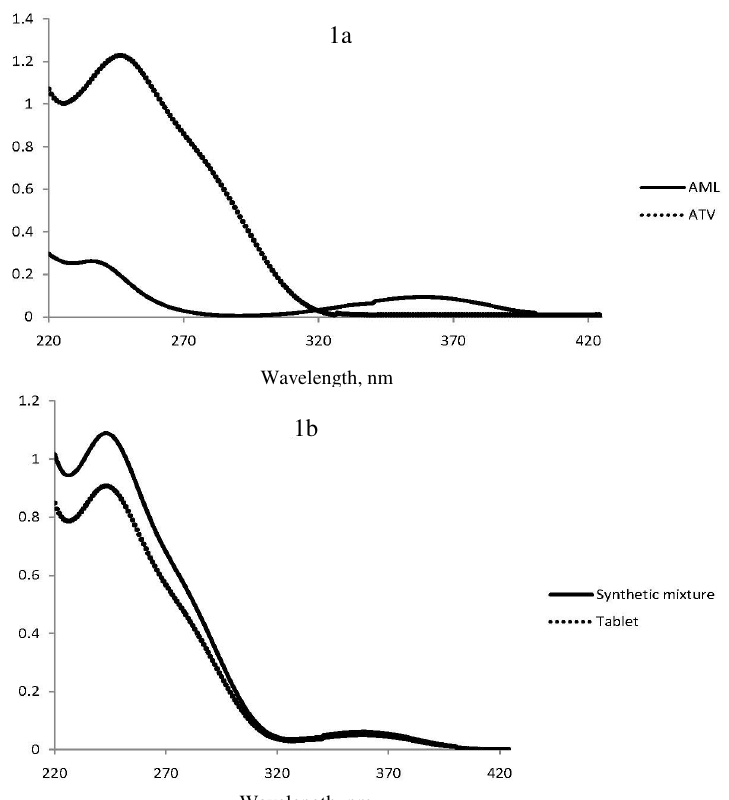
Figure 1. The absorption spectra of ATV and AML (1a), synthetic mixture and tablet (1b) solutions in methanol Table 1. Statistical results to ATV better calibration models